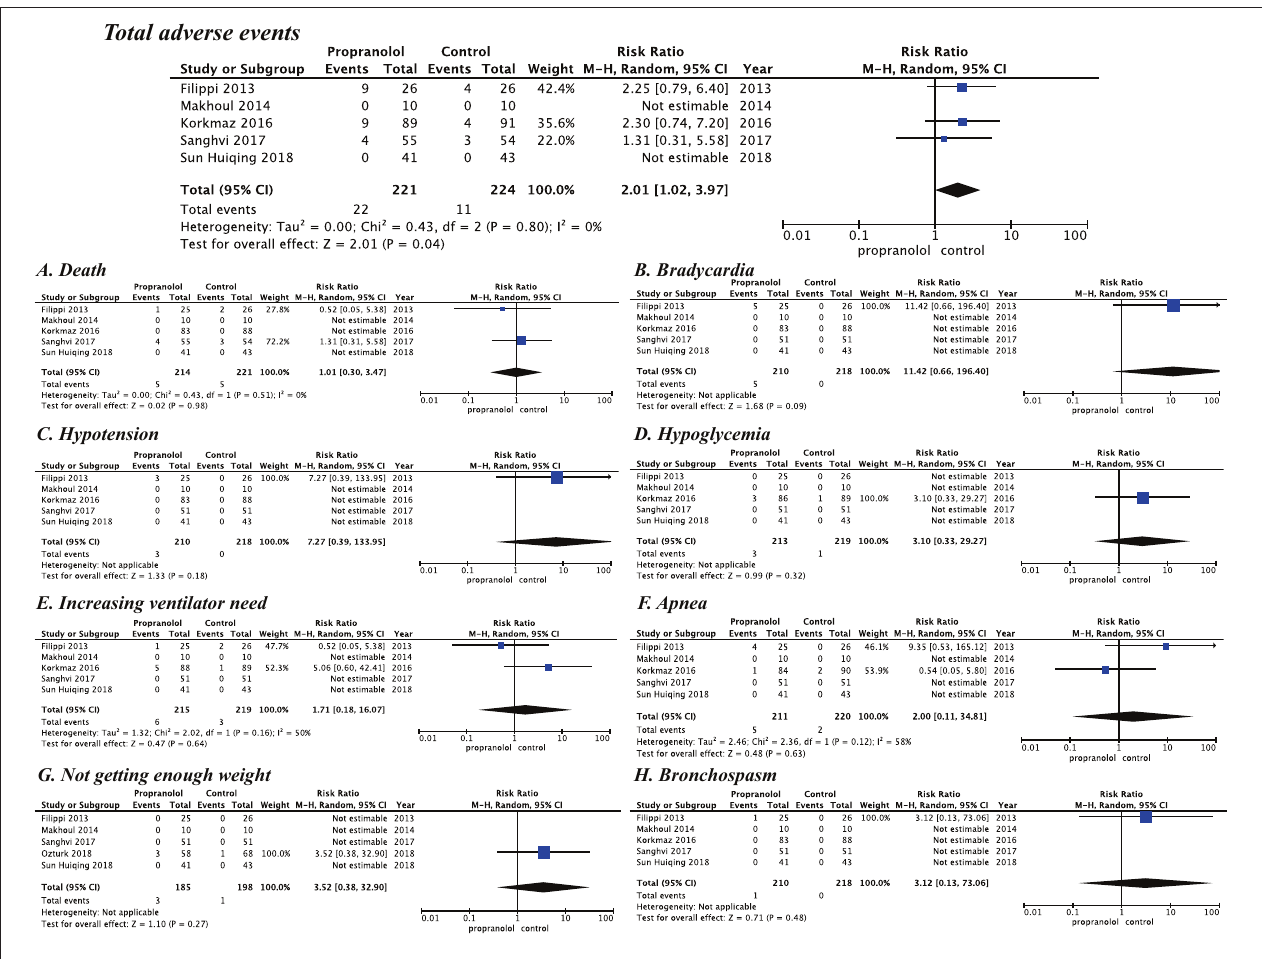
FIGURE 4 | Safety of propranolol oral administration in the prevention and treatment of retinopathy of prematurity based on adverse events. (A) Death, (B) Bradycardia, (C) Hypotension, (D) Hypoglycemia, (E) Increasing ventilator need, (F) Apnea, (G) Not getting enough weight, and (H)